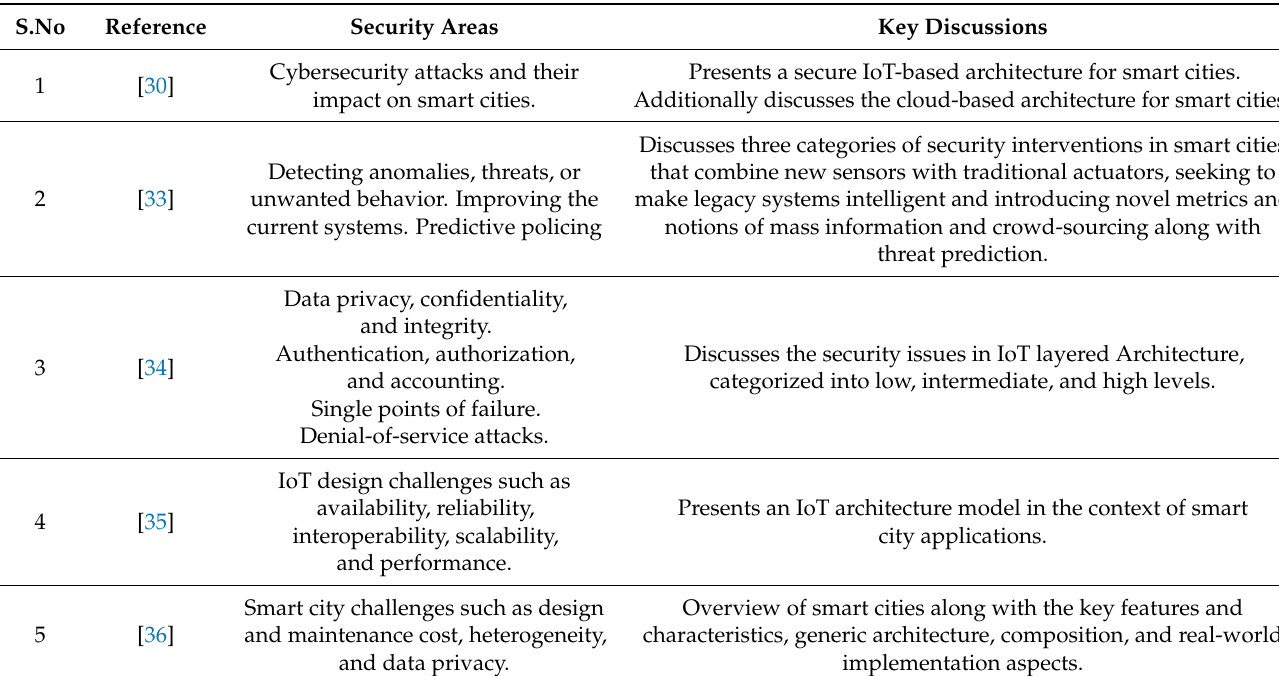
Table 1. Summary of Important Discussions on Smart City Security.